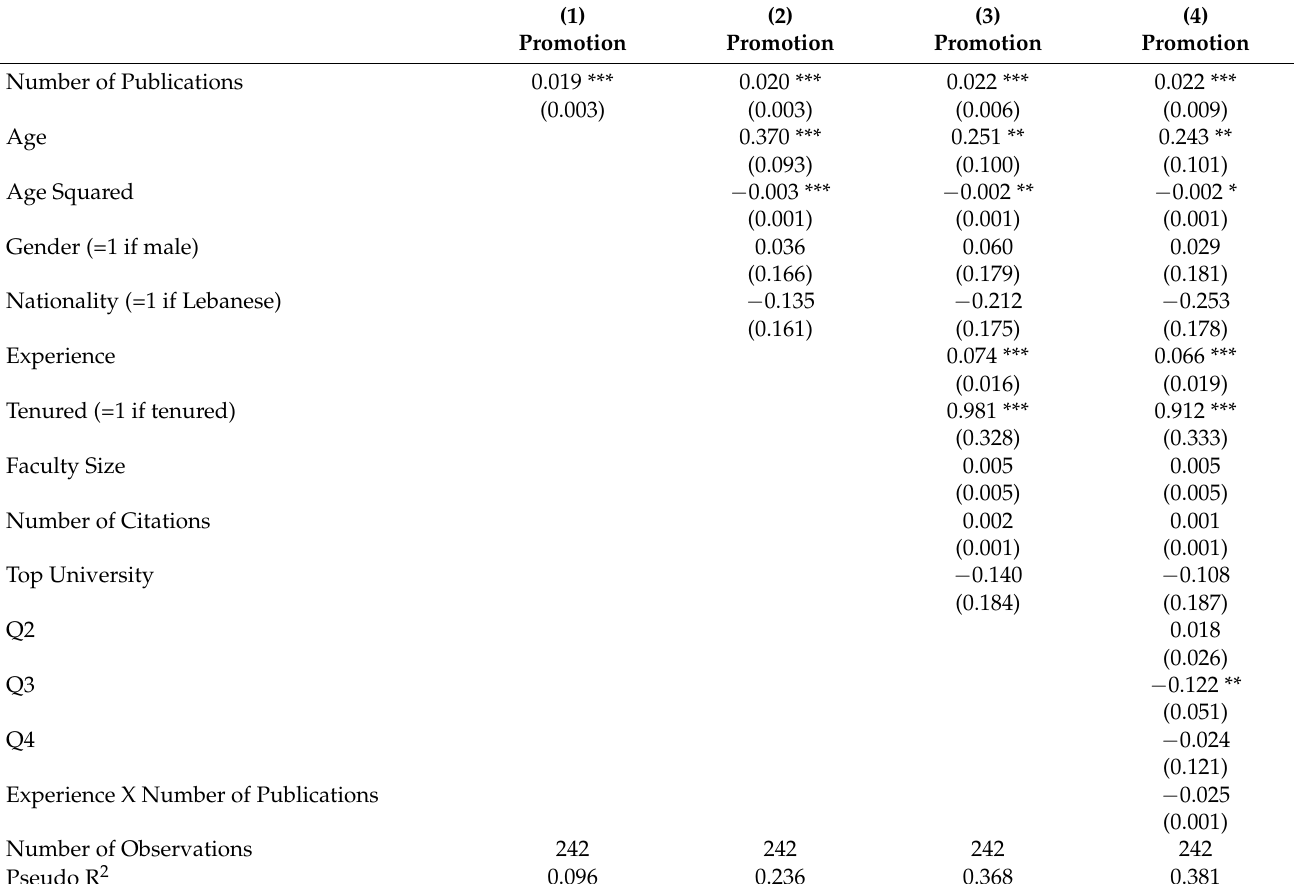
Table 3. Results of the Ordered Probit model, benchmark